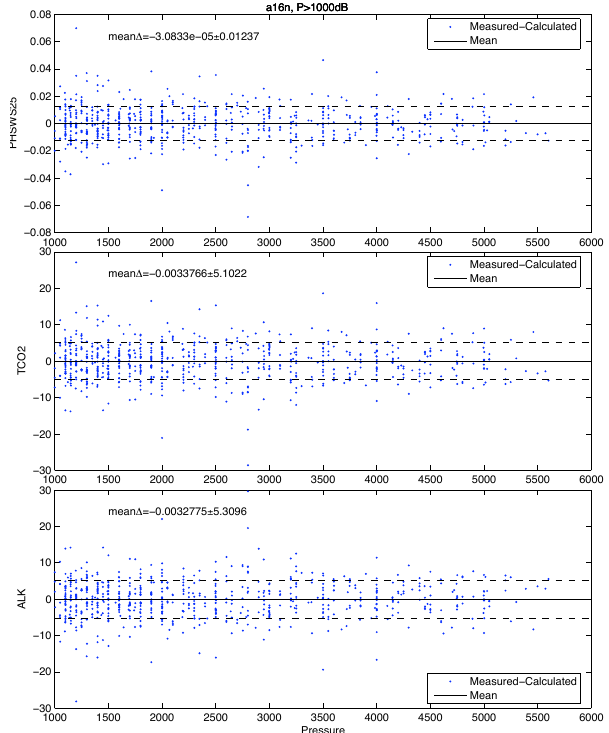
Figure 2. Comparison of measured and calculated carbon system values from Cruise #86; 33RO20030604. Regardless of which pair was used to calculate the third, the mean di ff erence is statistically indistinguishable from zero. The standard deviation of the di ff er- ence is only marginally larger than the precision estimate based on replicate